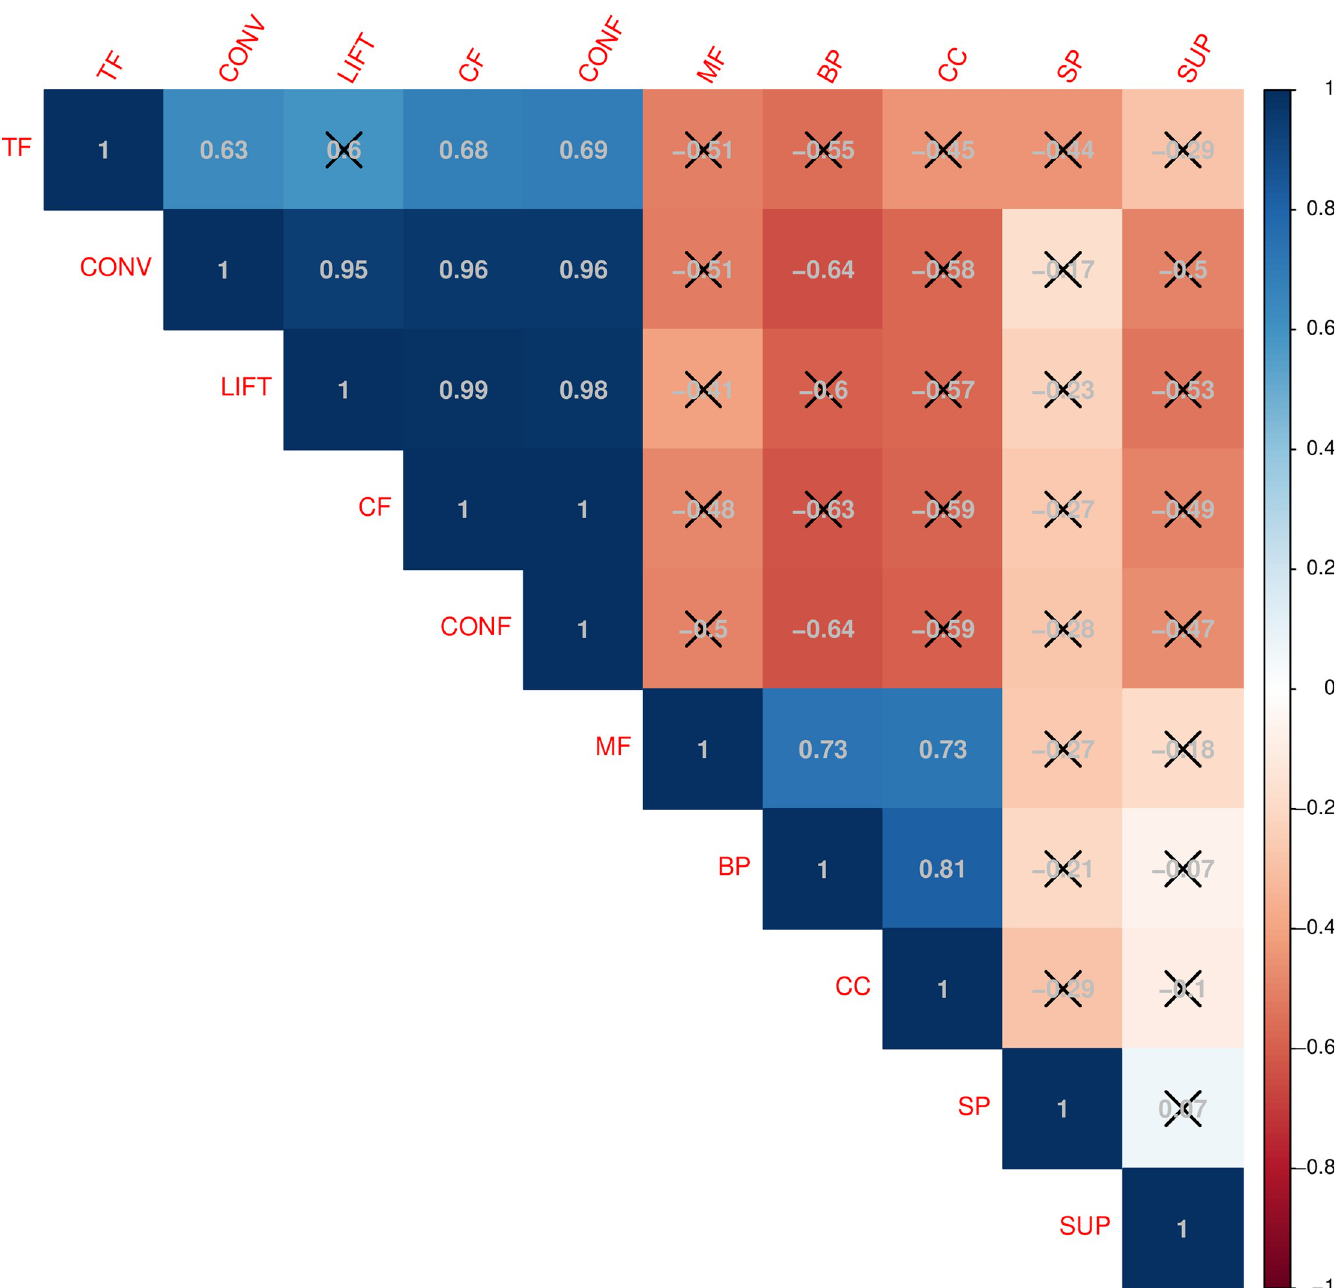
Fig 5. Correlation between traditional quality metrics and biological quality measures by rule in the sequential rules discovered from the whole GSE77962 dataset (LCD and VLCD groups). R 2 values quantify the level of correlation for each pair of measures while the level of statistical significance (adjusted by Bonferroni multiple test correction) is evidenced with an X for P-values > 0.05 and nothing for P-values <